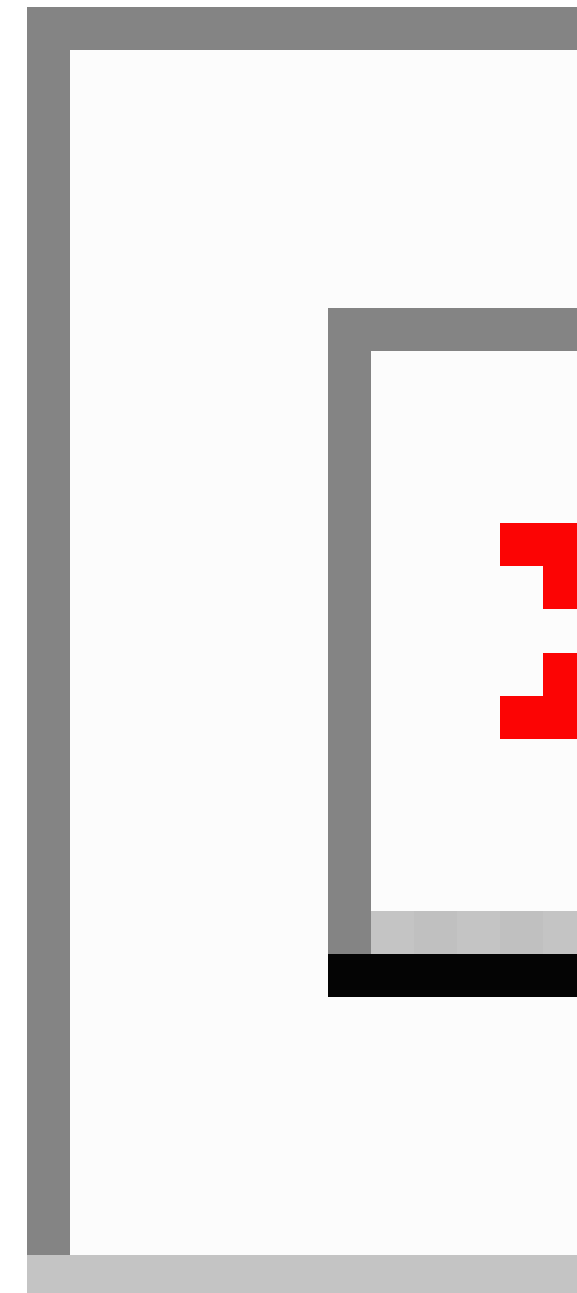
Figure 3. Questionnaire